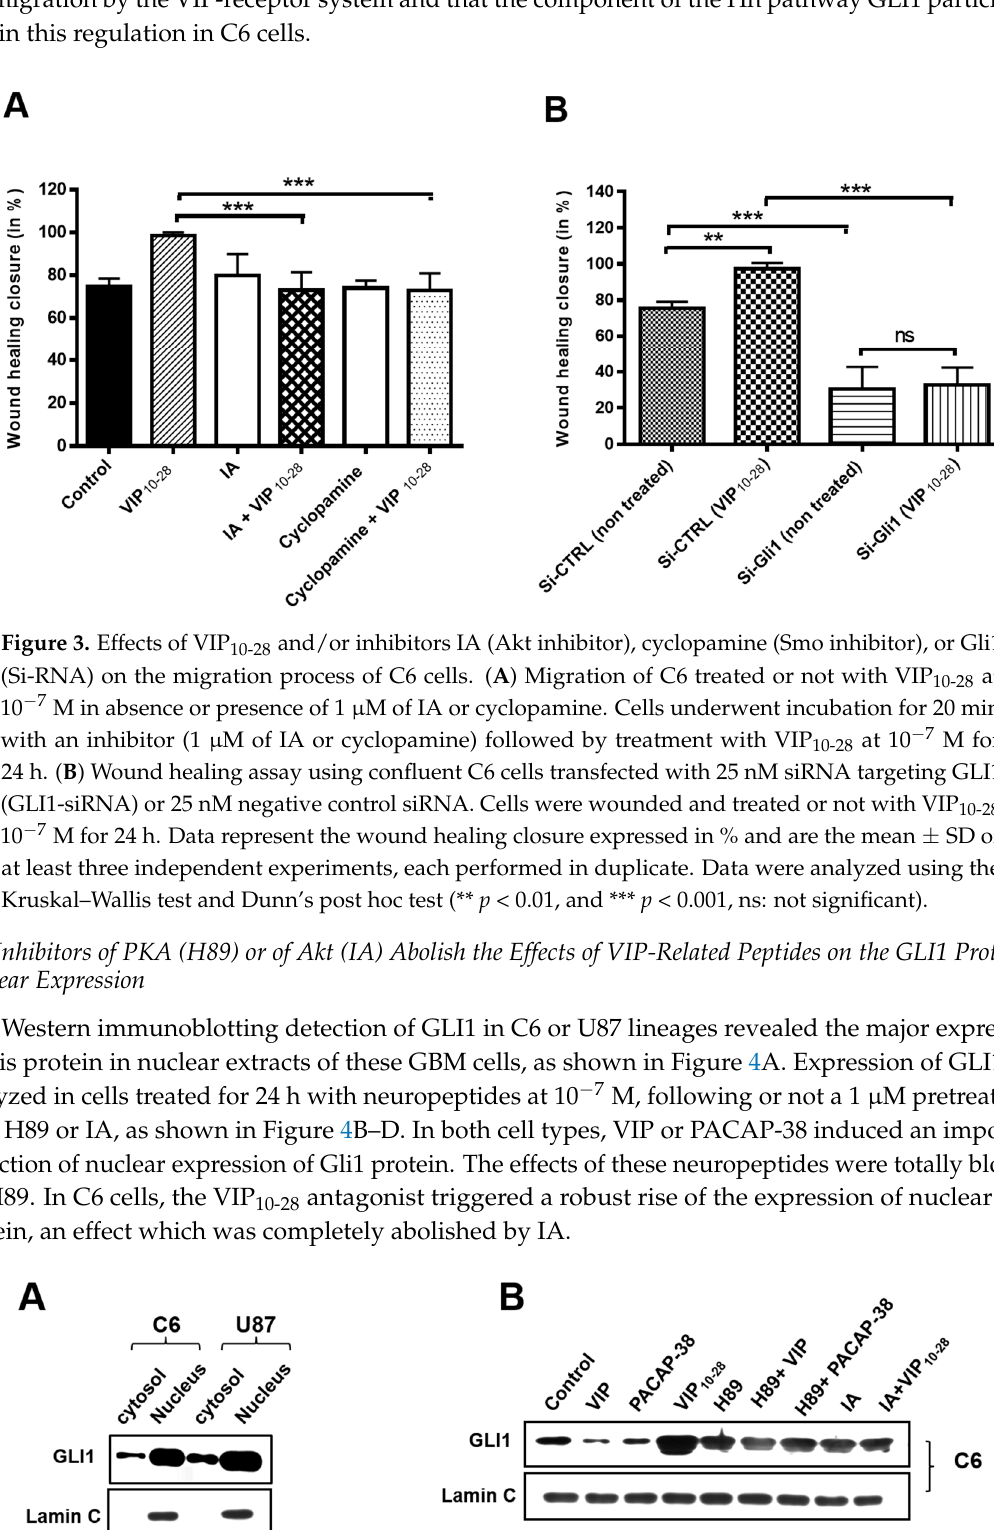
Figure 4. Effects of VIP, PACAP-38, VIP 10-28 , and/or inhibitors H89 (PKA inhibitor), IA (Akt inhibitor) on the expression and intracellular localization of GLI1 protein in C6 and U87 cells. ( A ) Western immunoblotting of GLI1 proteins in C6 and U87 cells. Cytosolic and nuclear proteins of cells were resolved by SDS-PAGE, transferred to membranes, and further probed with antibody anti-GLI1, anti- GAPDH, or anti-Lamin-C. GAPDH and Lamin-C proteins are used as a control for cytosolic and nuclear extracts, respectively. ( B ) Western immunoblotting of GLI1 proteins in C6 and U87 cells treated or not with neuropeptides in absence or presence of pathways inhibitors. Nuclear proteins were extracted from cells treated or not with neuropeptides at 10 -7 M for 24 h. Cells were incubated for 20 min with an inhibitor (1 µM of H89 or IA) followed by treatment with VIP, PACAP-38, or VIP 10- 28 at 10 -7 M for 24 h. Nuclear proteins of cells were resolved by SDS-PAGE, transferred to membranes and further probed with antibody anti-GLI1 or anti-Lamin-C. ( C , D ) Cumulative data from three independent experiments, in same conditions as in ( B ), after densitometry quantification of immunoblotting (WB) data. Quantification data are the mean ± SD. Data were analyzed using the Kruskal–Wallis test and Dunn’s post hoc test (* p < 0.05 and ** p < 0.01, ns: not significant). 2.5. PACAP-38 Triggers a Time-Dependent Decrease of Phospho-Akt and Elevation of Phospho-PTEN Protein Expression in C6 Cells C6 cells were treated with 10 -7 M PACAP-38 for increasing periods of time ranging from 30 min to 24 h. Western immunoblotting detection of total and phosphorylated forms of Akt and phosphorylated PTEN was then carried out in cell lysates from these experiments, as shown in Figure 5A–C. PACAP-38 time-dependently decreased the phospho-Akt/total Akt ratio with a very strong but transient maximal effect after 6 h of treatment. At 24 h, this ratio returned to its initial level at the onset of the experiment. On the opposite, the phospho-PTEN/GAPDH ratio started to significantly increase after 2 h of treatment with a maximal increase of about 10-fold after 3 h. Then this ratio dropped back to its initial value after 24 h. Increased phosphorylation of PTEN by PACAP-38 was abolished in the presence of the PKA inhibitor H89, as shown in Figure 5D,E.